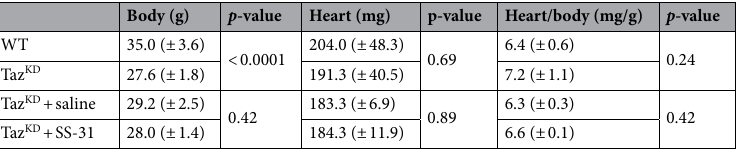
Table 1. Heart and body weights of mice. All values are means ± SD (WT and Taz KD : n = 9/group; Taz KD + saline and Taz KD + SS-31: n = 4/group). p -values were assessed by Student’s